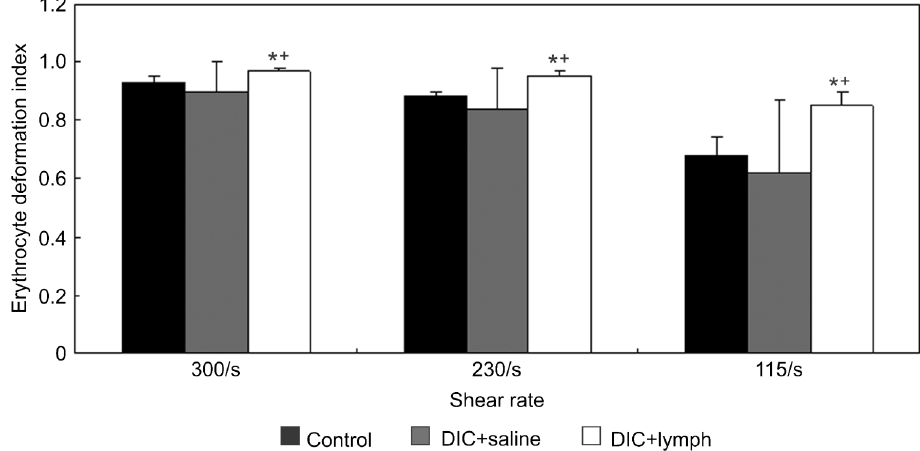
Figure 9. Changes of erythrocyte deformability in the three rat groups studied. Data are reported as means ± SD for 10 rats. *P , 0.05 compared to the control group; + P , 0.05 compared to the DIC + saline group (one-way